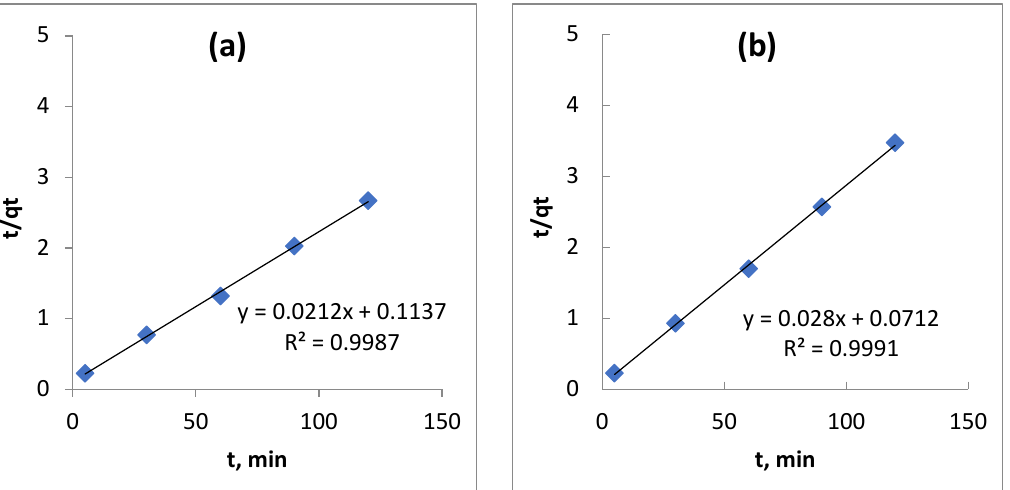
Figure 17. The pseudo-first-order kinetics model for adsorption of oil onto adsorbents: ( a ) ABs and ( b ) ARs (1g adsorbents, pH 6.5, Temp. 25 °C).